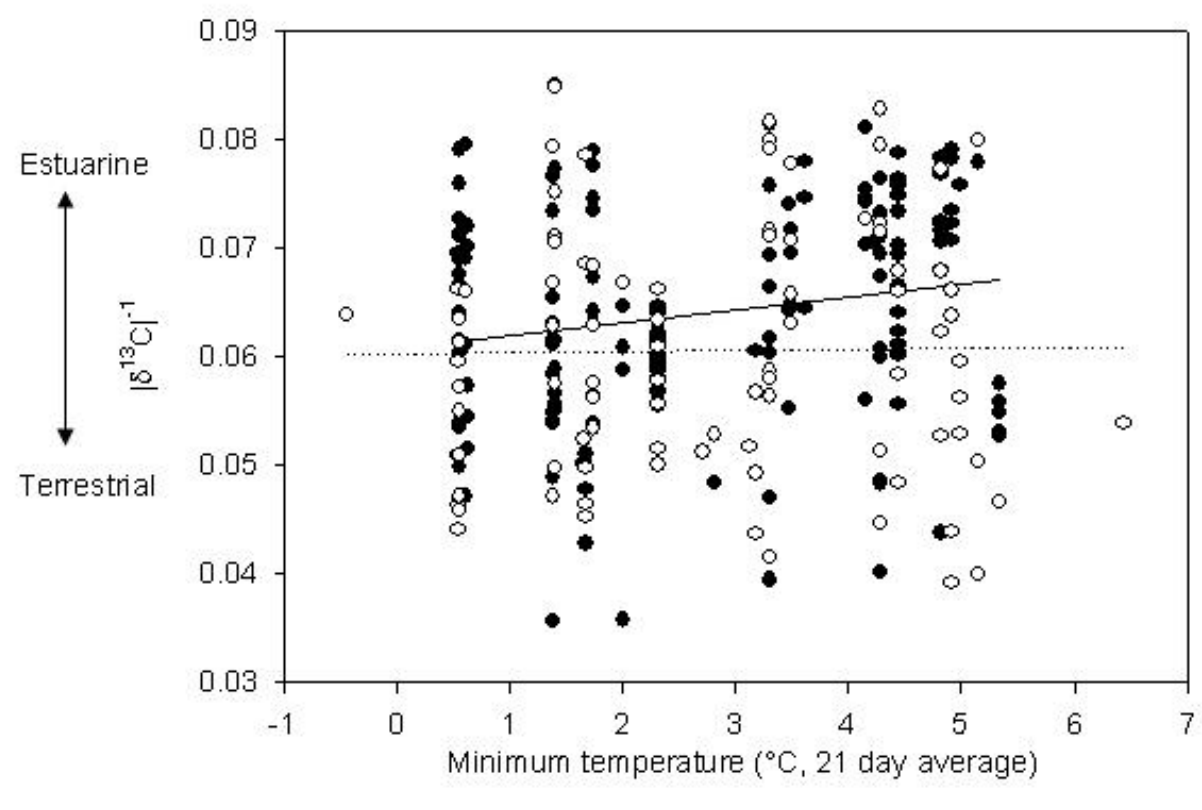
Fig. 5 . Relative use of fields (as represented by transformed d 13 C values) and mean minimum temperature for previous 21-d period, separated by age class, adults represented by black filled circles, juveniles by open circles. The Y-axis represents a transformation of d 13 C data (| d 13 C| -1 ) and is an index of relative use of each ecosystem (estuarine versus terrestrial) in Dunlin diet. The linear regression line of significantly increasing field use with declining temperature is shown in black for adults. The trend line shown for juveniles (dotted line) is for comparison only and is not significant. [ See